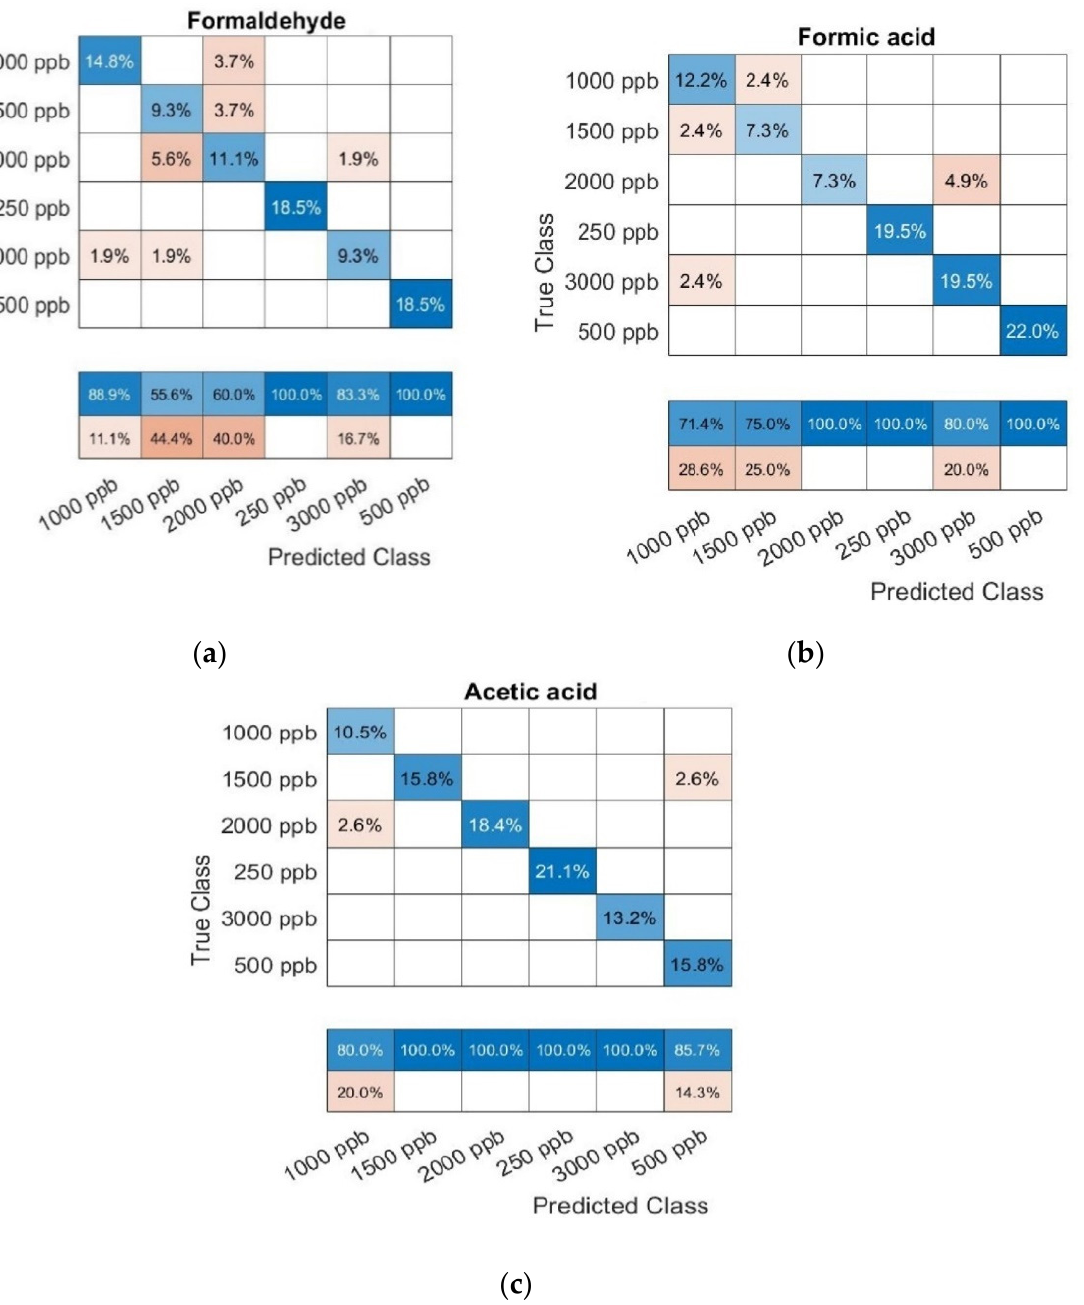
Figure 7. Confusion matrix results from a 10–fold cross–validated support vector machine classification analysis performed for concentrations from 0.25 to 3 ppm for ( a ) formaldehyde, ( b ) formic acid, and ( c ) acetic acid.